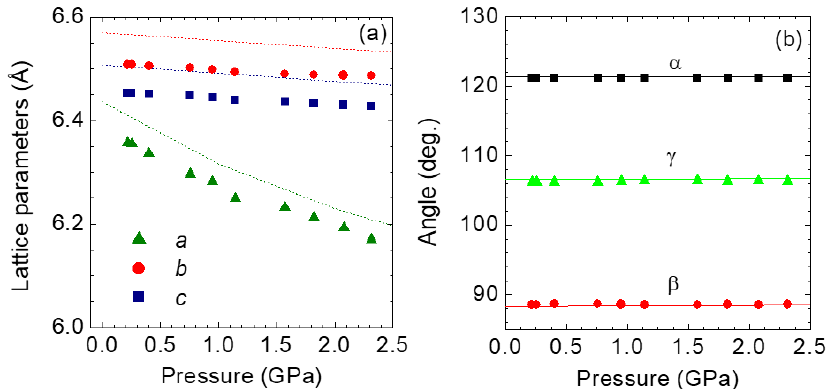
Figure 6. Pressure dependence of the unit-cell parameters ( a ) and triclinic angles ( b ) of 1T-ReS 2 as obtained with powder XRD measurements (solid symbols). The dashed curves show the results of DFT calculations using a PBE functional with D3 correction for van der Waals interactions.